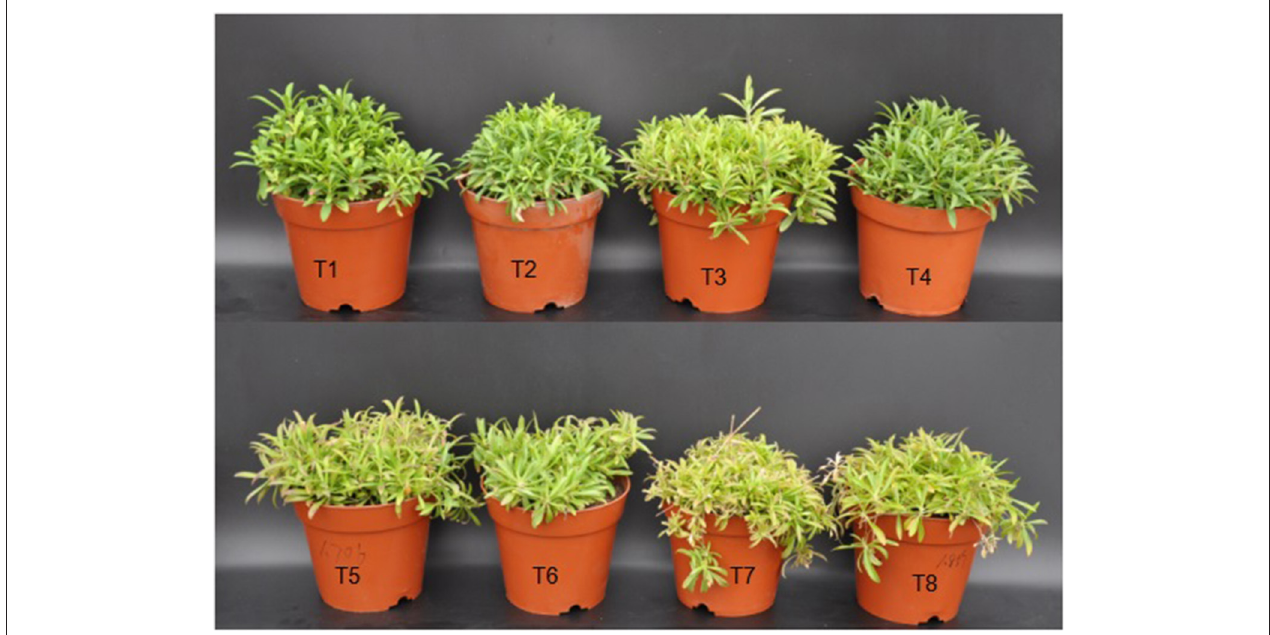
FIGURE 1 | Effects of SA on the growth in D. superbus grown under salt stress (means ± SD ). T1, distilled water; T2, distilled water with 0.5 mmol SA; T3, 0.3% NaCl; T4, 0.3% NaCl with 0.5 mmol SA; T5, 0.6% NaCl; T6, 0.6% NaCl with 0.5 mmol SA; T7, 0.9% NaCl; T8, 0.9% NaCl with 0.5 mmol SA.